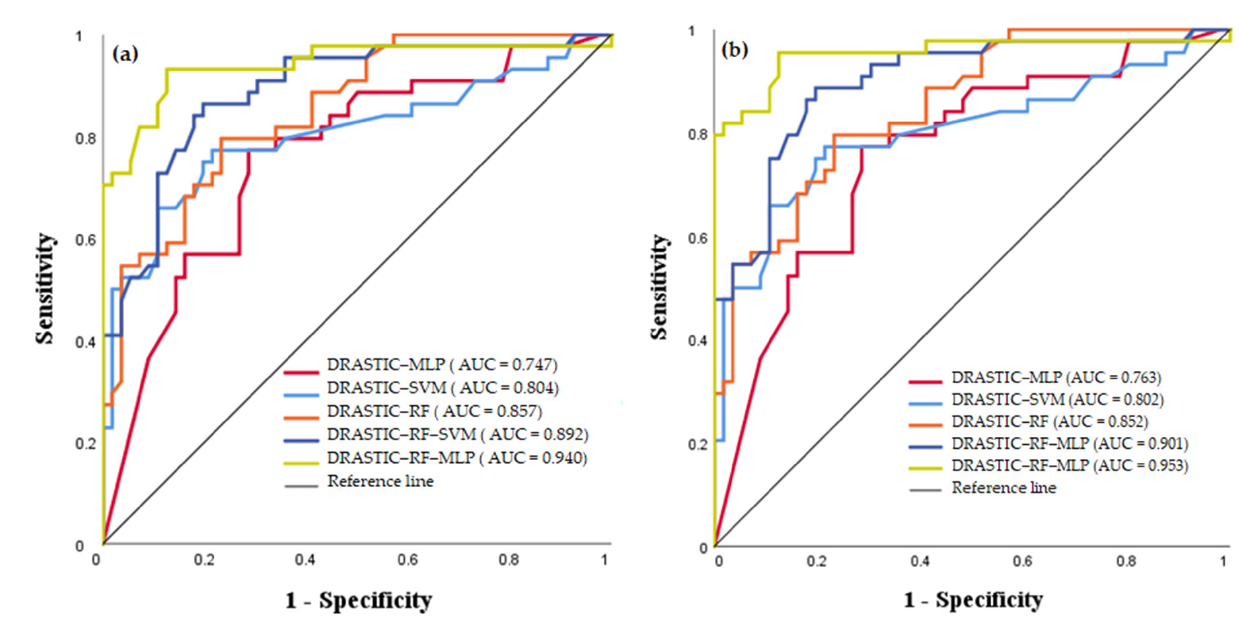
Figure 8. ( a ) ROC curves of success rate; ( b ) ROC curves of prediction rate.